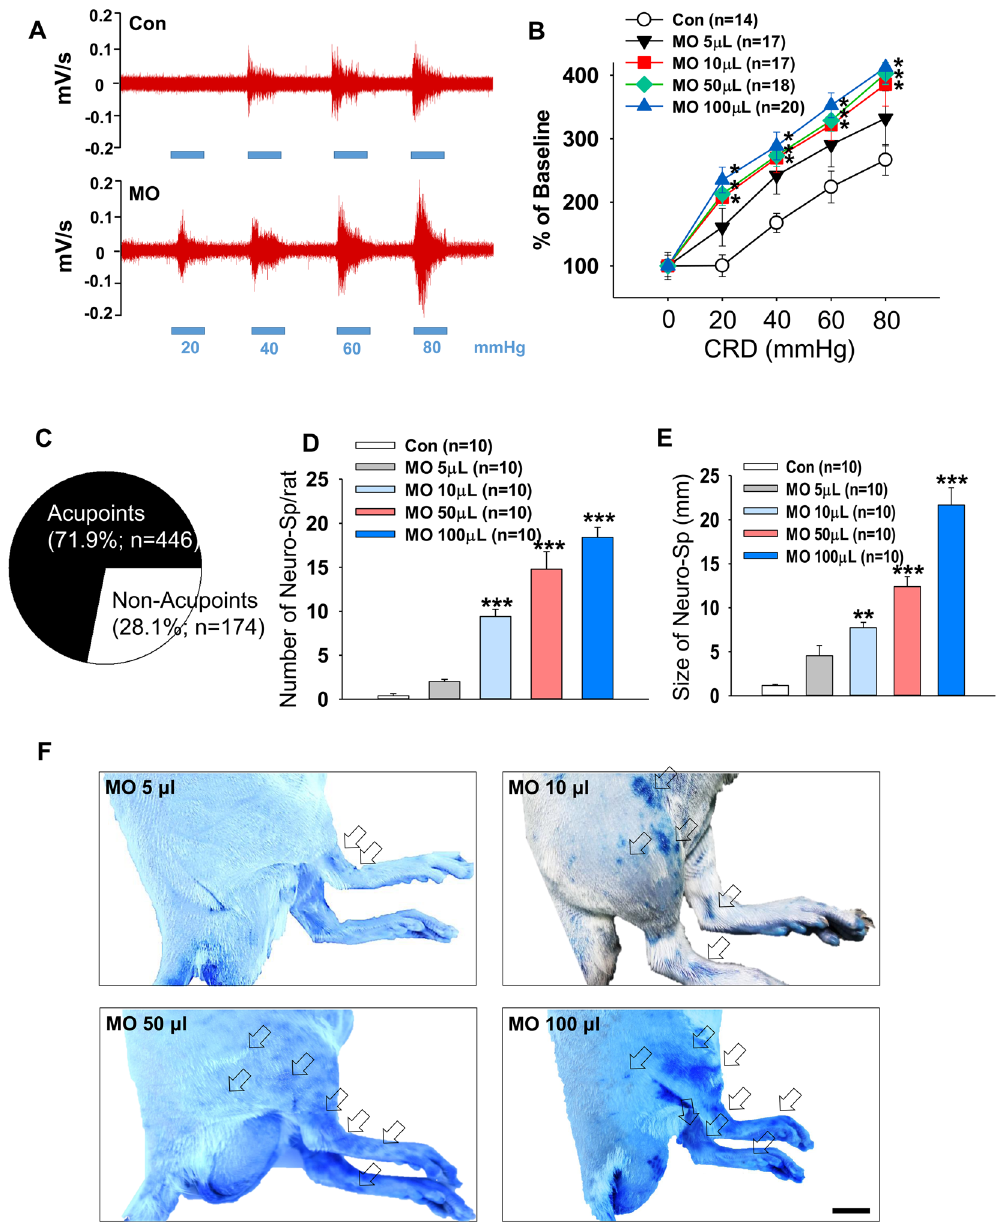
Figure 1. Increased number and size of Neuro-Sps along with severity of colonic pain in MO-treated rats. ( A ) Representative EMG activities in response to colorectal distension (CRD) in control or MO-infused rats. ( B ) EMG activities in the external oblique muscle in response to graded CRD in control or MO-infused rats. * p < 0.05 vs. Con. ( C ) Correlation of the anatomic location between Neuro-Sp and acupoints in MO-infused rats (n = 40). ( D ) Number of Neuro-Sps in MO-infused rats. *** p < 0.001 vs. Con. ( E ) Size of Neuro-Sps in MO-infused rats. ** p < 0.01, *** p < 0.001 vs. Con. ( F ) Representative images of Neuro-Sps in MO-infused rats. Bar = 20 mm. MO, mustard oil; Con, Control. Arrows indicate prominent Neuro-Sps at each of